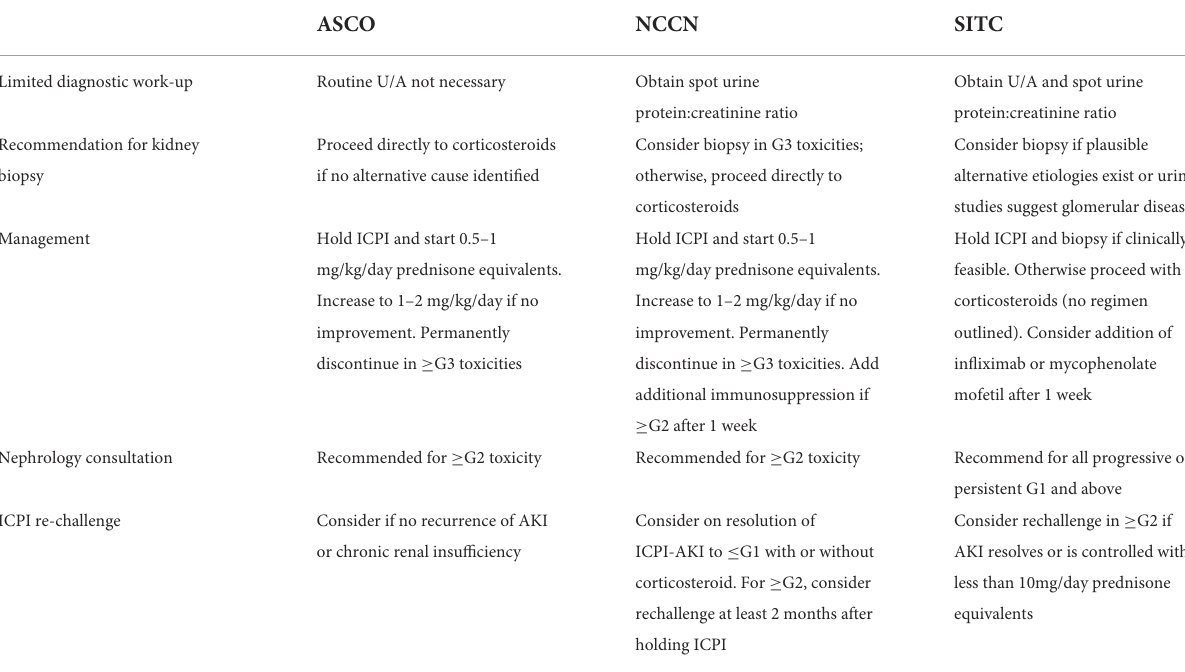
TABLE 2 Comparison of clinical practice guidelines for management of ICPI